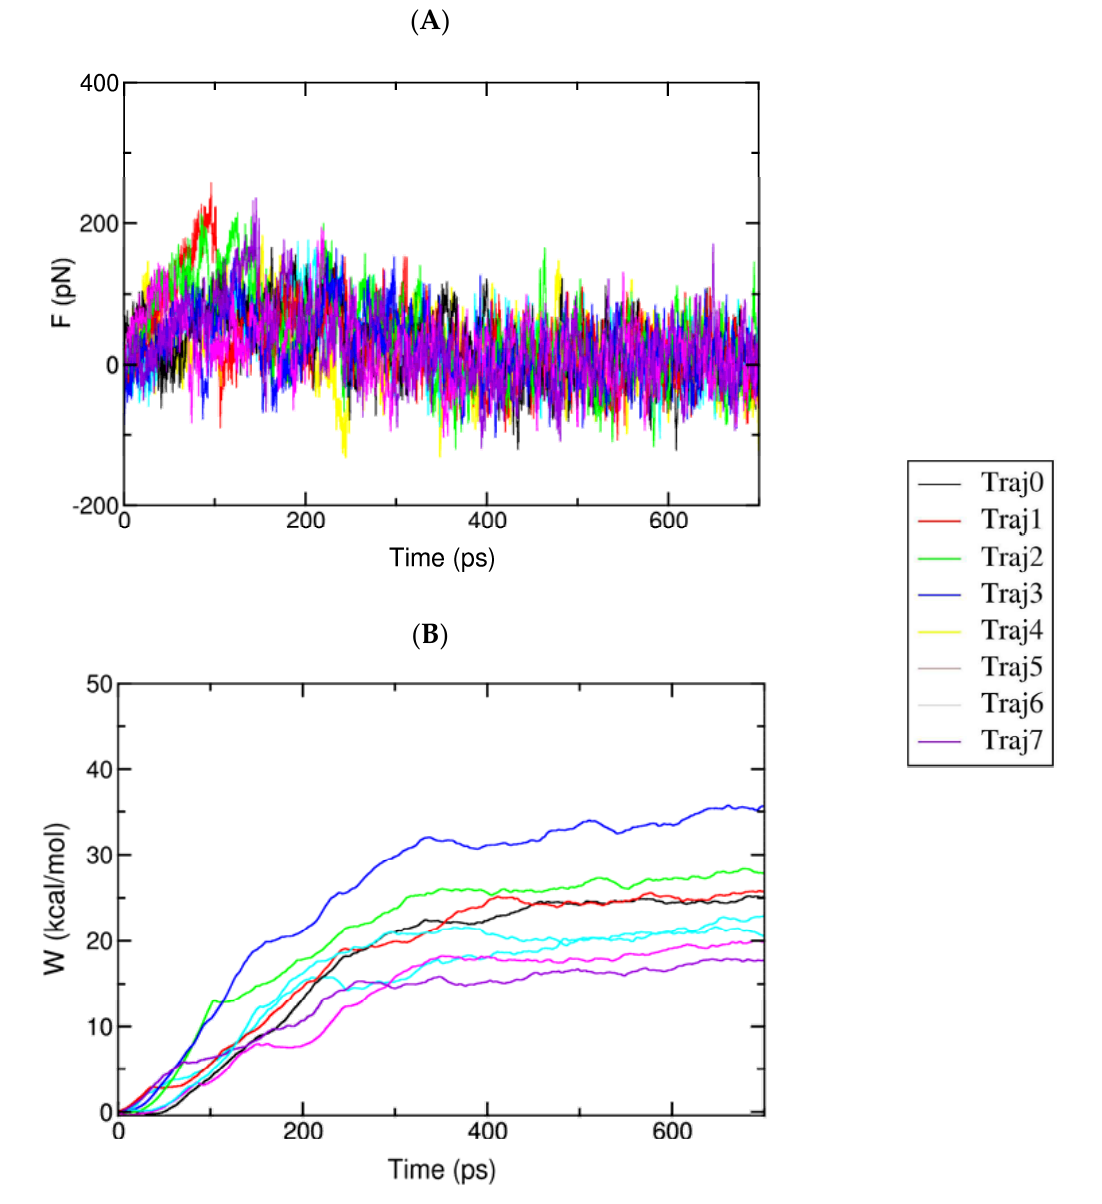
Figure 7. ( A ) The mean force of complexes over eight independent SMD trajectories. The data were monitored every 0.1 ps; ( B ) The mean work of complexes during eight independent SMD trajecto ‐ ries.